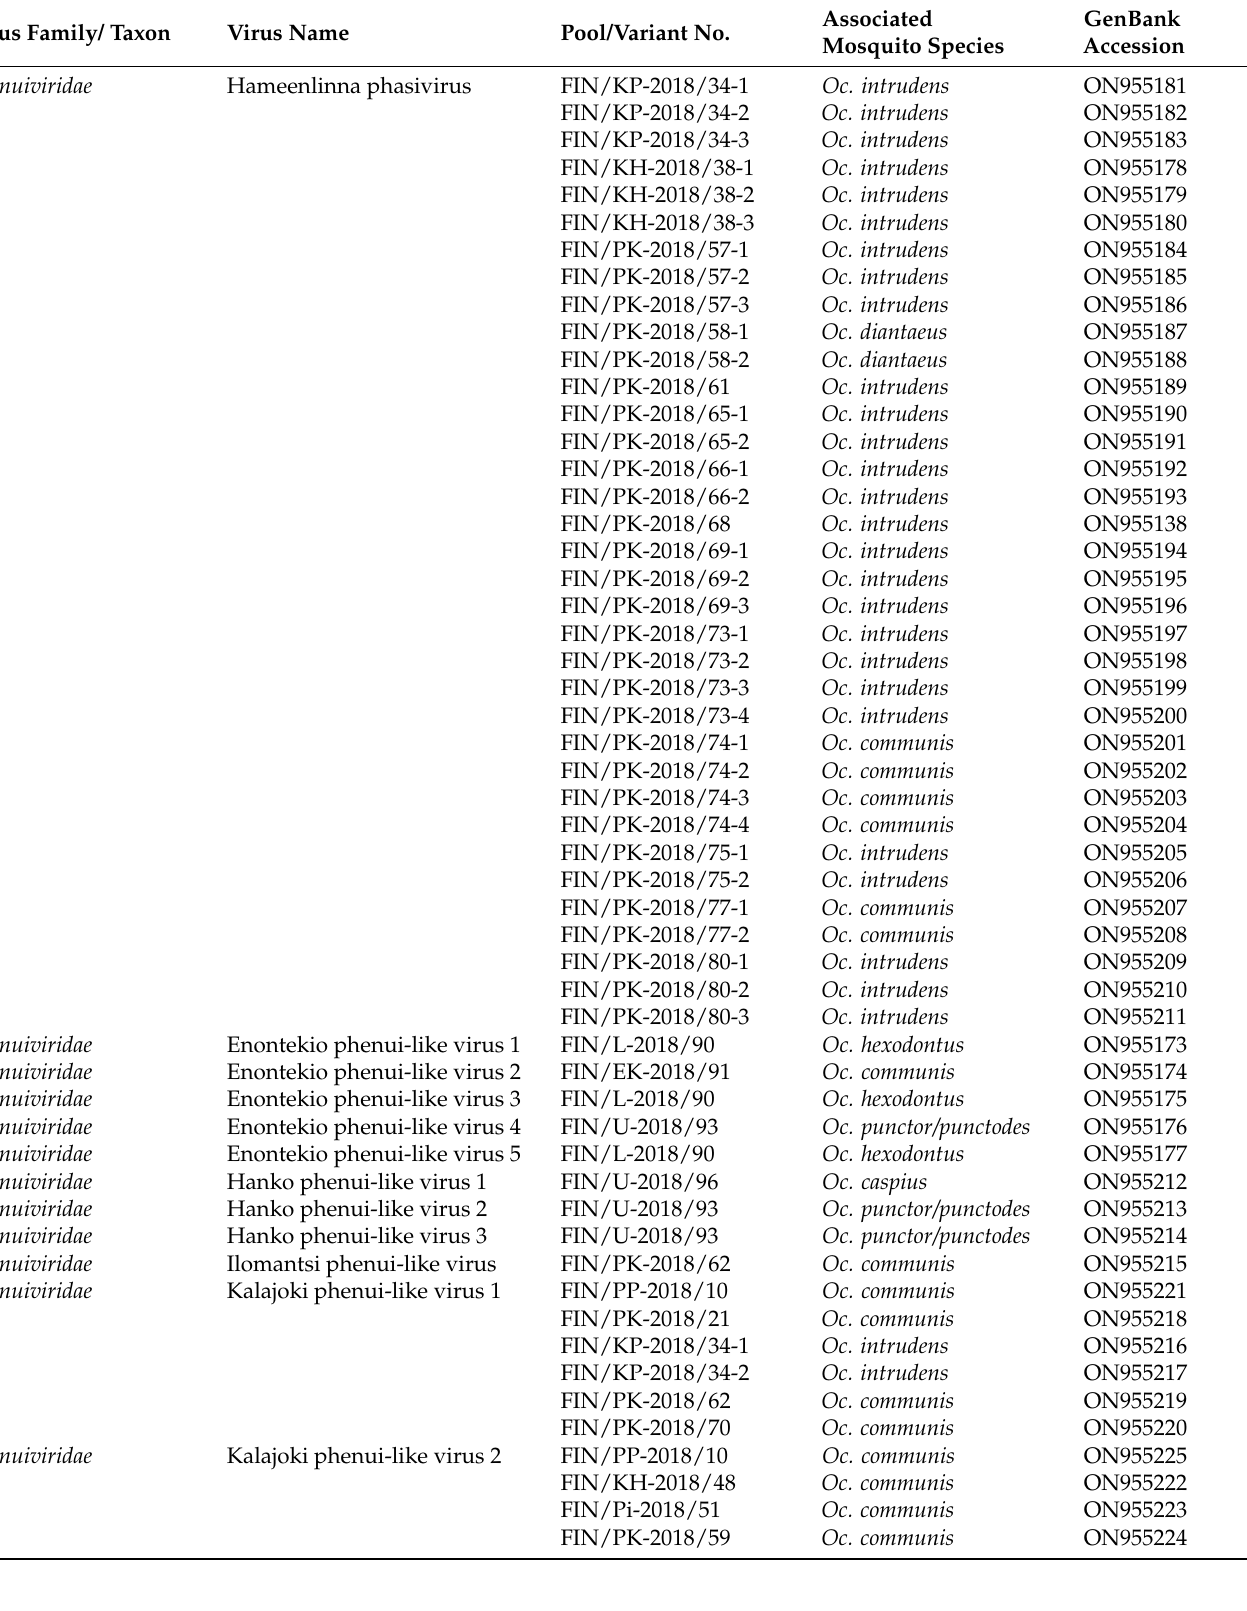
Table 4. − ssRNA viruses sequenced from Finnish mosquitoes, part 2. Previously described viruses are shaded